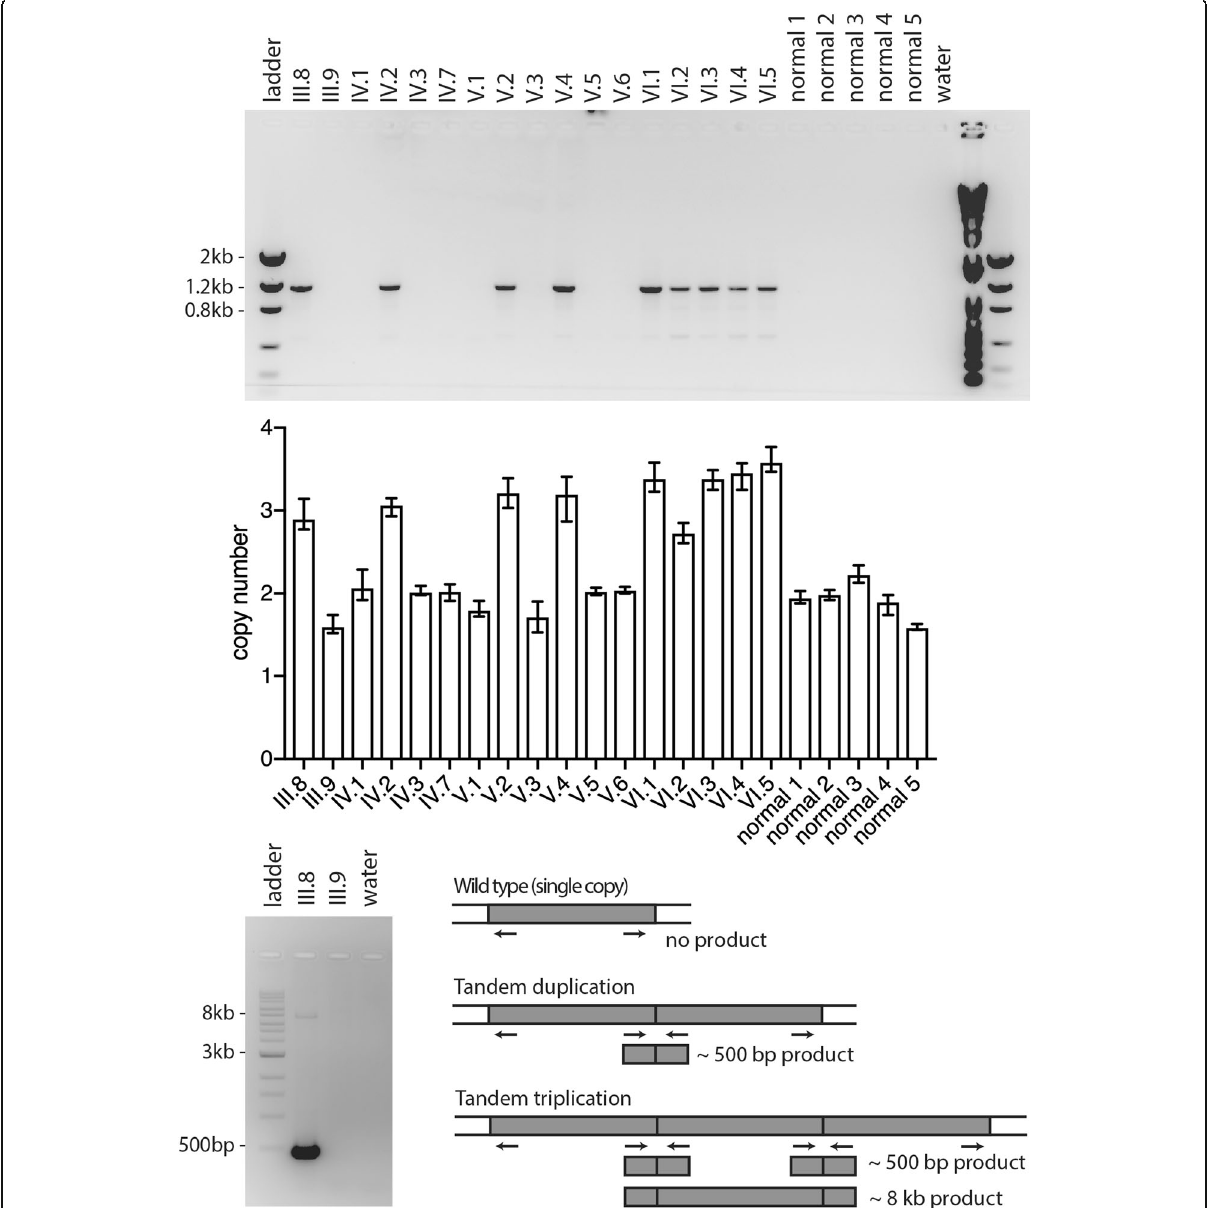
Fig. 3 Genetic testing results. Top, 1% agarose gel with breakpoint polymerase chain reaction testing of cavitary optic disc anomaly pedigree and unrelated individuals. Middle, Results of pre-designed quantitative polymerase chain reaction copy number assay. Error bars represent minimum and maximum copy number as reported by CopyCaller software. Bottom left, 0.7% agarose gel electrophoresis of products of long range PCR. Bottom right, breakpoint primer design showing lack of product in wild type haplotype, ~ 500 bp product in tandem duplication, and ~ 500